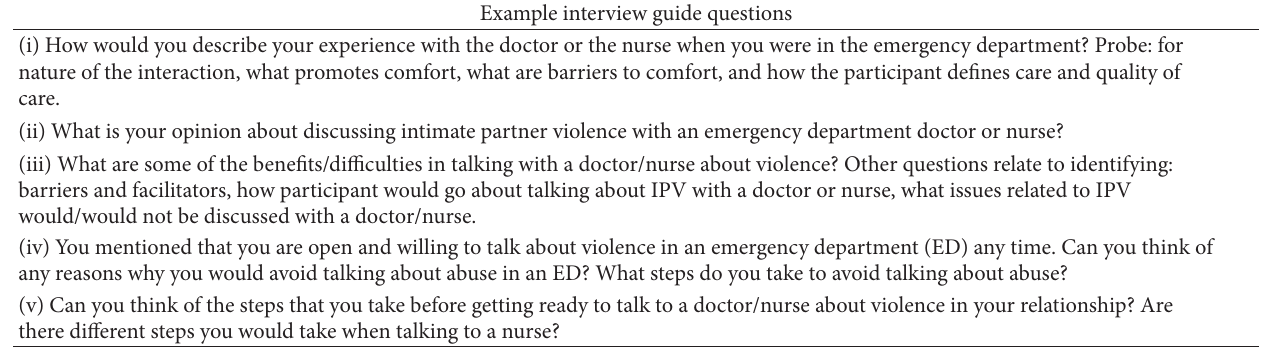
Example interview guide